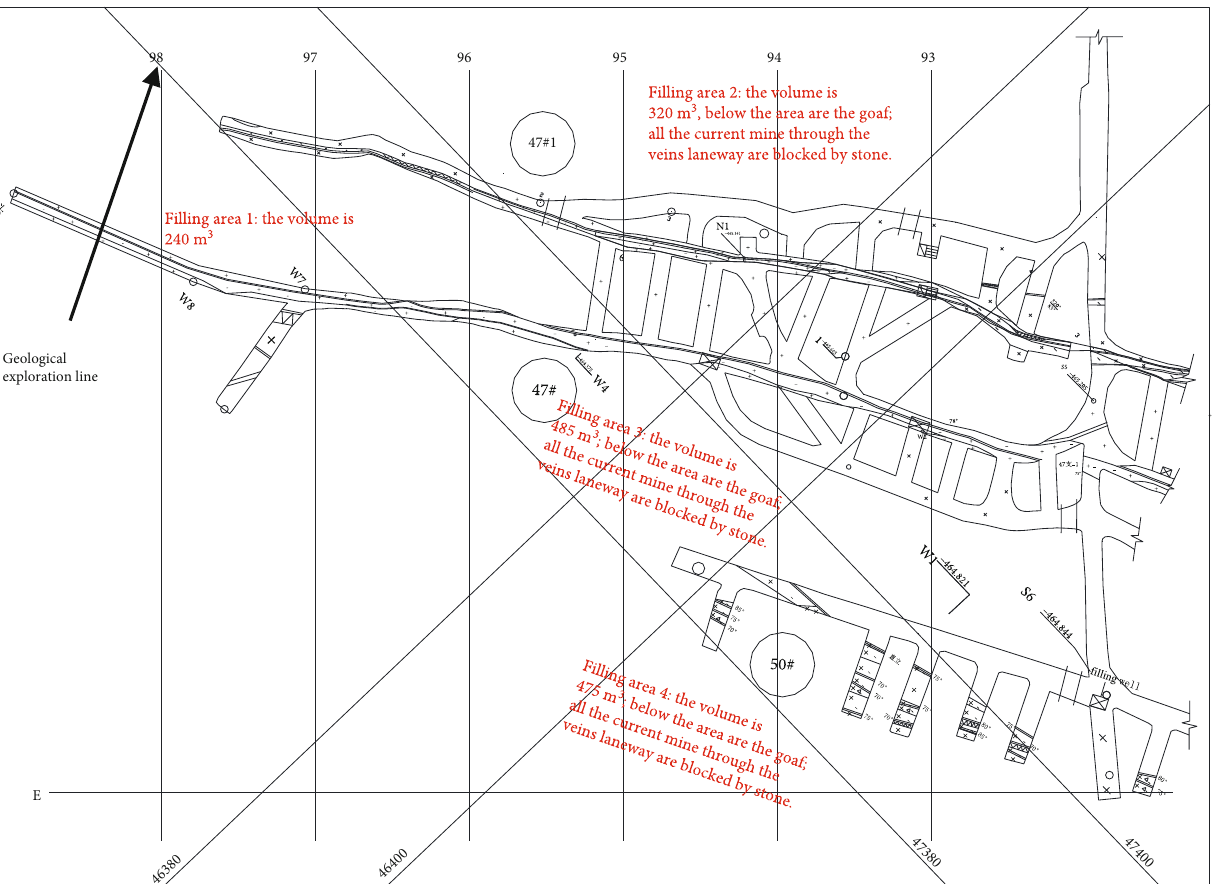
Figure 6: Deposed roadway fi lling experiment site